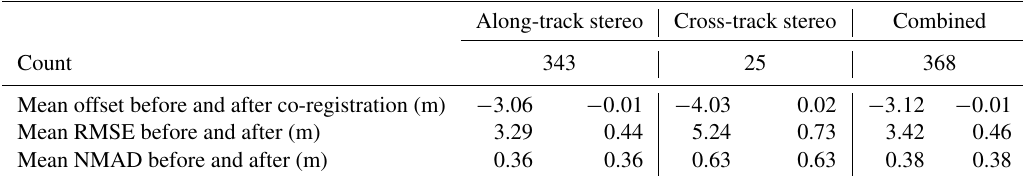
Table 2. Statistics for elevation difference between WorldView/GeoEye DEMs and altimetry control points, before and after DEM co- registration.